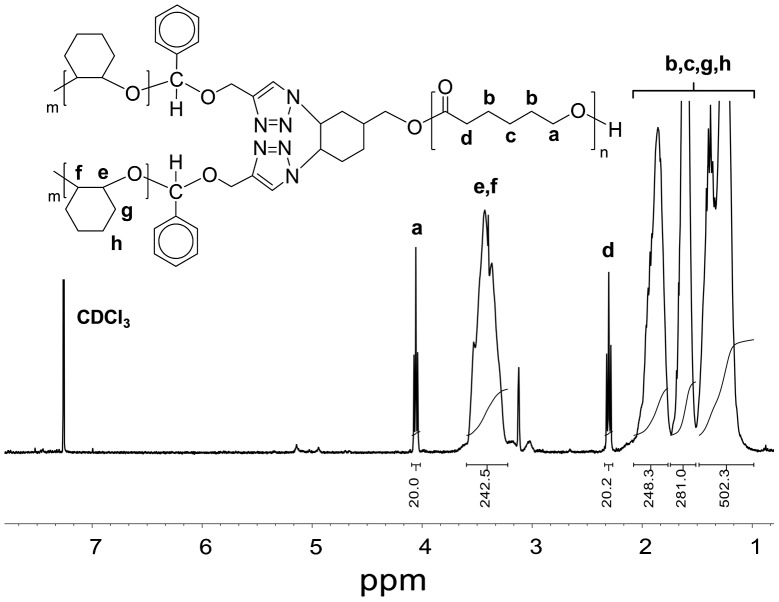

1H NMR spectra of PCL(PCHO)2 miktoarm star type copolymer in CDCl3.